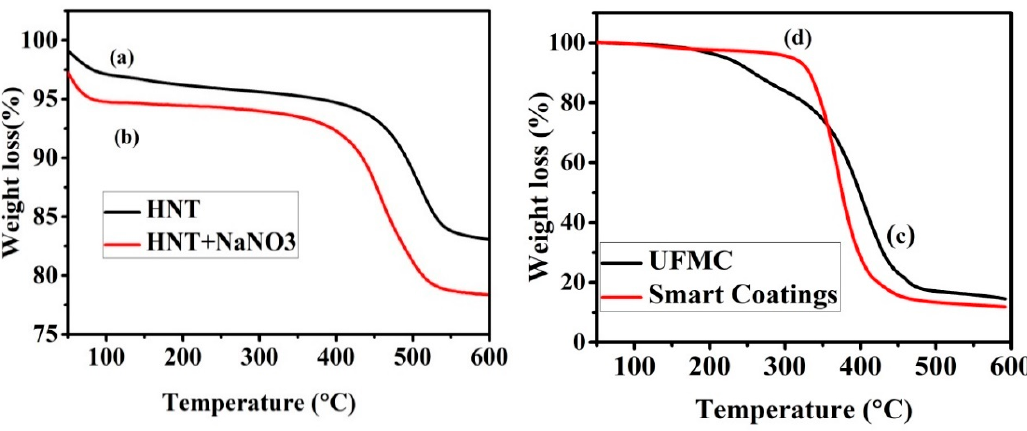
Figure 8. Thermogravimetric (TGA) curves: ( a ) pristine HNTs, ( b ) HNTs loaded with NaNO 3 , ( c ) encapsulated UFMCs, and ( d ) nanocomposite coatings.